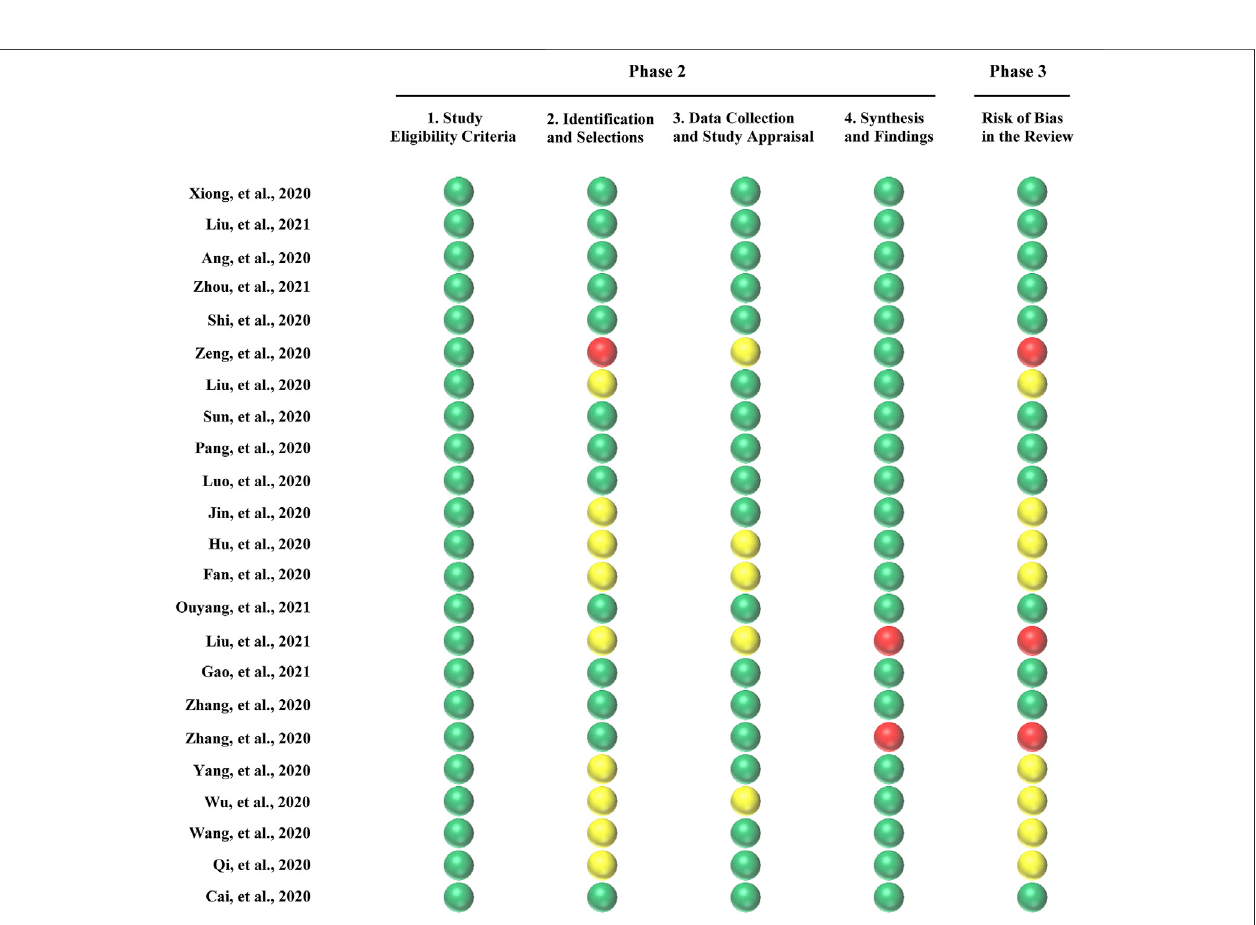
FIGURE 3 | Mapping of risk of bias of the included systematic reviews (SRs). Green color represented low risk bias, and red color represented high risk bias, and yellow color represented unclear risk bias. The ROBIS tool items were represented on the lateral axis and the included SRs was represented on the vertical axis.